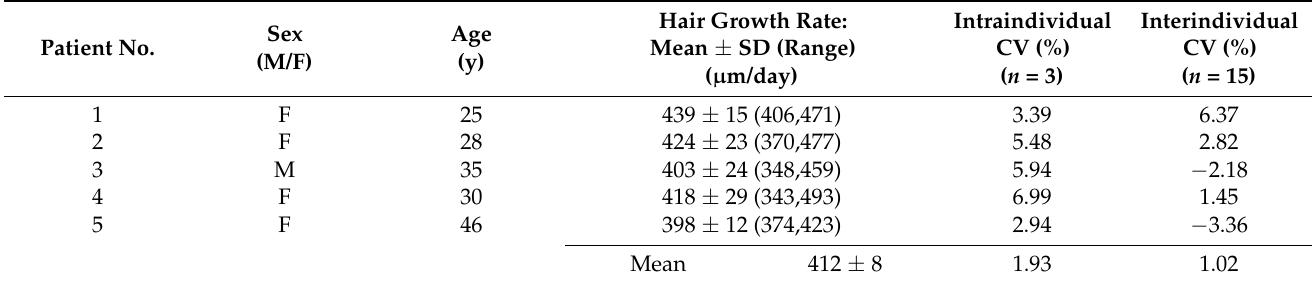
Table 2. Hair growth rate measured by arsenic longitudinal distribution along hair strands.